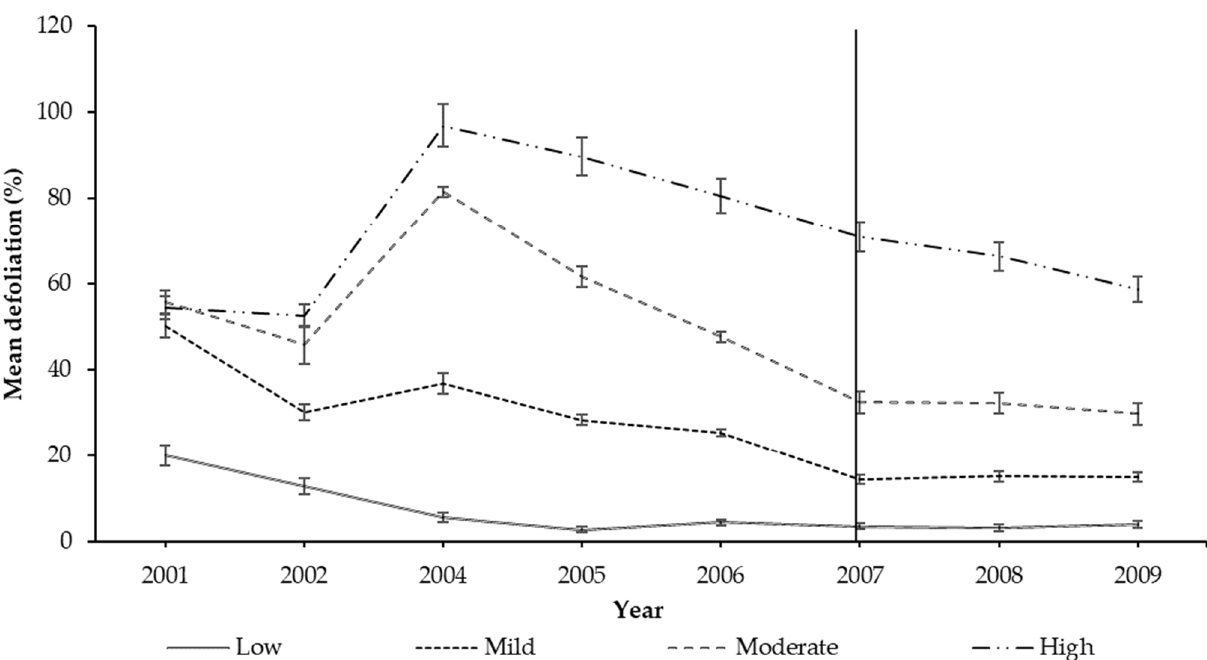
Figure 1. The annual mean defoliation ( ± standard error) of the four defoliation classes. Defoliation intensity was assessed in May or early June, before the elongation of new needles. Thus, the defoliation values correspond to the defoliation status of the previous autumn, presented in the x-axis. Outbreak peak was assessed in May 2005, indicating the defoliation status for autumn 2004. The estimates before 2007 are based on trees in the plots established in 2002 ( n = 70). The whole data set ( n = 197) is included in the calculations after 2007, shown on the right-hand side of the vertical line. No assessments were carried out in 2003.